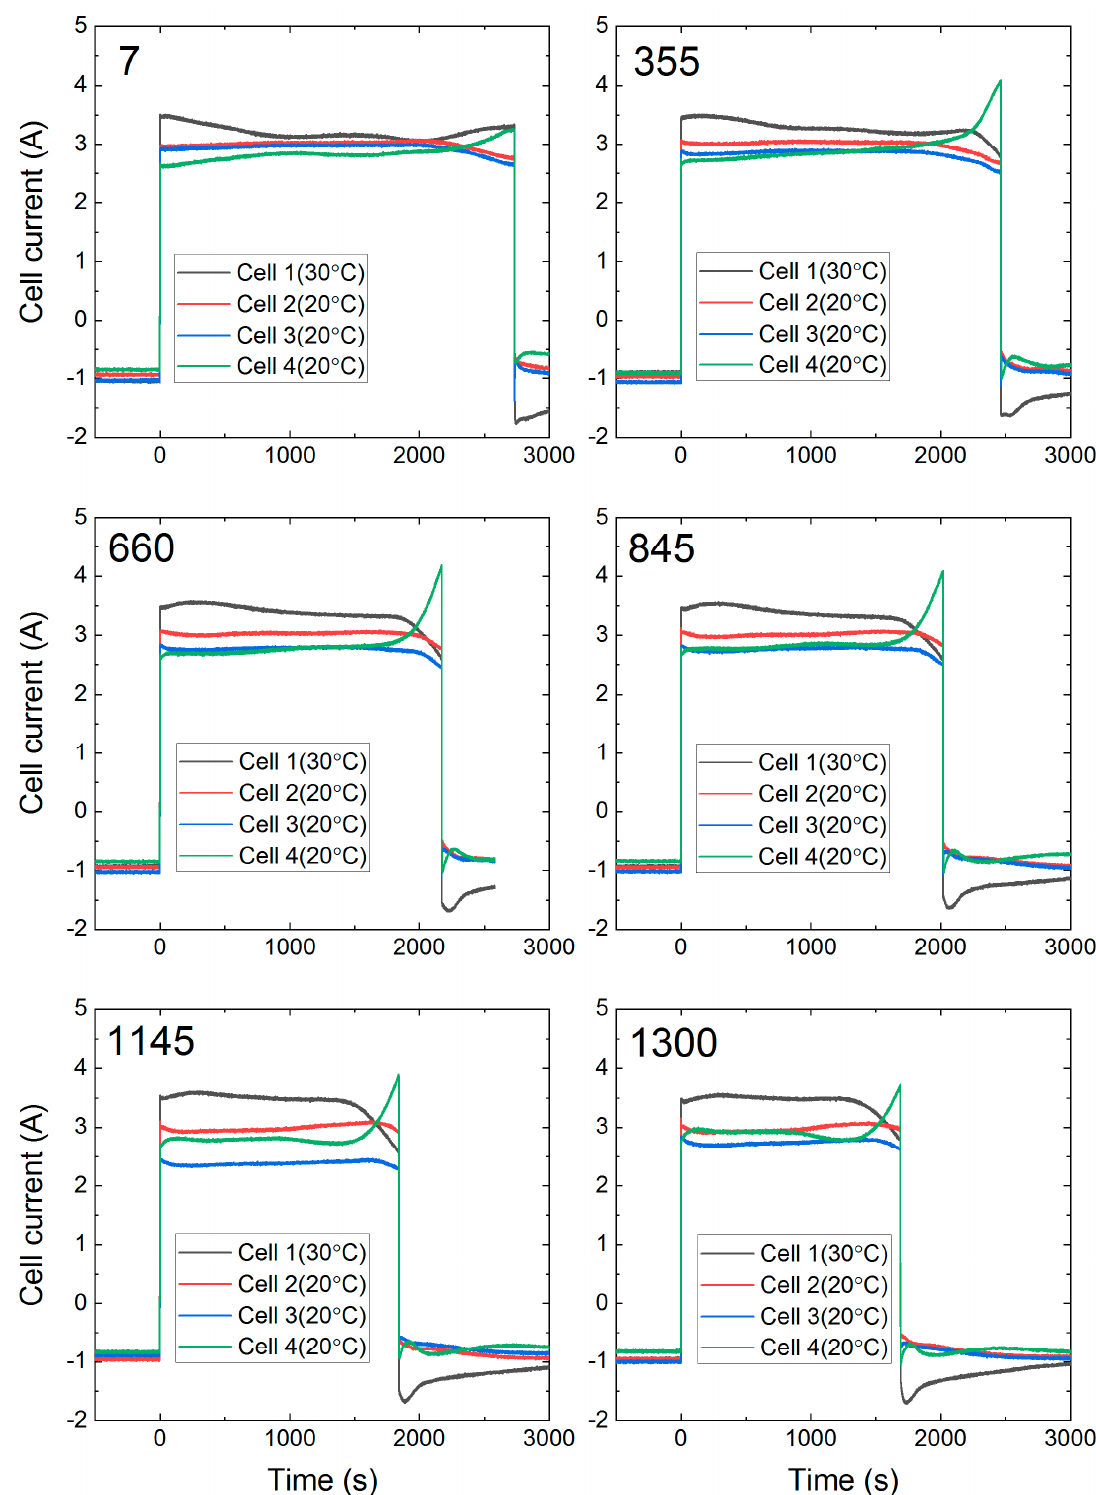
Figure 8. Discharge current distribution in cells in the 4P module cycling for selected cycles. The positive and negative currents represent the discharge and charging state of the module. The numbers represent the cumulative cycling number.